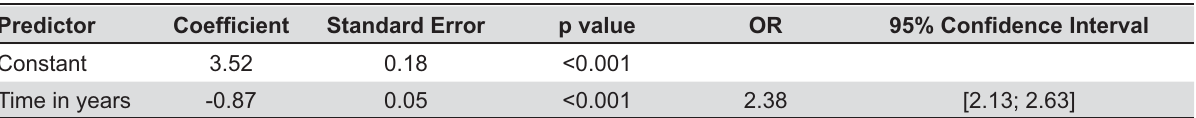
Table 6- (cid:2)(cid:3)(cid:4)(cid:5)(cid:6)(cid:7)(cid:8)(cid:2)(cid:9)(cid:10)(cid:11)(cid:4)(cid:12)(cid:13)(cid:4)(cid:14)(cid:2)(cid:7)(cid:15)(cid:11)(cid:7)(cid:15)(cid:12)(cid:12)(cid:4)(cid:10)(cid:5)(cid:2)(cid:16)(cid:10)(cid:7)(cid:2)(cid:6)(cid:5)(cid:6)(cid:9)(cid:8)(cid:17)(cid:4)(cid:5)(cid:11)(cid:2)(cid:13)(cid:18)(cid:15)(cid:2)(cid:4)(cid:5)(cid:19)(cid:20)(cid:15)(cid:5)(cid:14)(cid:15)(cid:2)(cid:10)(cid:16)(cid:2)(cid:5)(cid:10)(cid:5)(cid:25)(cid:5)(cid:20)(cid:13)(cid:7)(cid:4)(cid:13)(cid:4)(cid:24)(cid:15)(cid:2)(cid:12)(cid:20)(cid:14)(cid:26)(cid:4)(cid:5)(cid:11)(cid:2)(cid:22)(cid:20)(cid:7)(cid:6)(cid:13)(cid:4)(cid:10)(cid:5)(cid:2)(cid:10)(cid:5)(cid:2)(cid:13)(cid:18)(cid:15)(cid:2)(cid:23)(cid:7)(cid:15)(cid:24)(cid:6)(cid:9)(cid:15)(cid:5)(cid:14)(cid:15)(cid:2)(cid:10)(cid:16)(cid:2)(cid:6)(cid:5)(cid:13)(cid:15)(cid:7)(cid:4)(cid:10)(cid:7)(cid:2) open bite in the total sample (n=1,377)